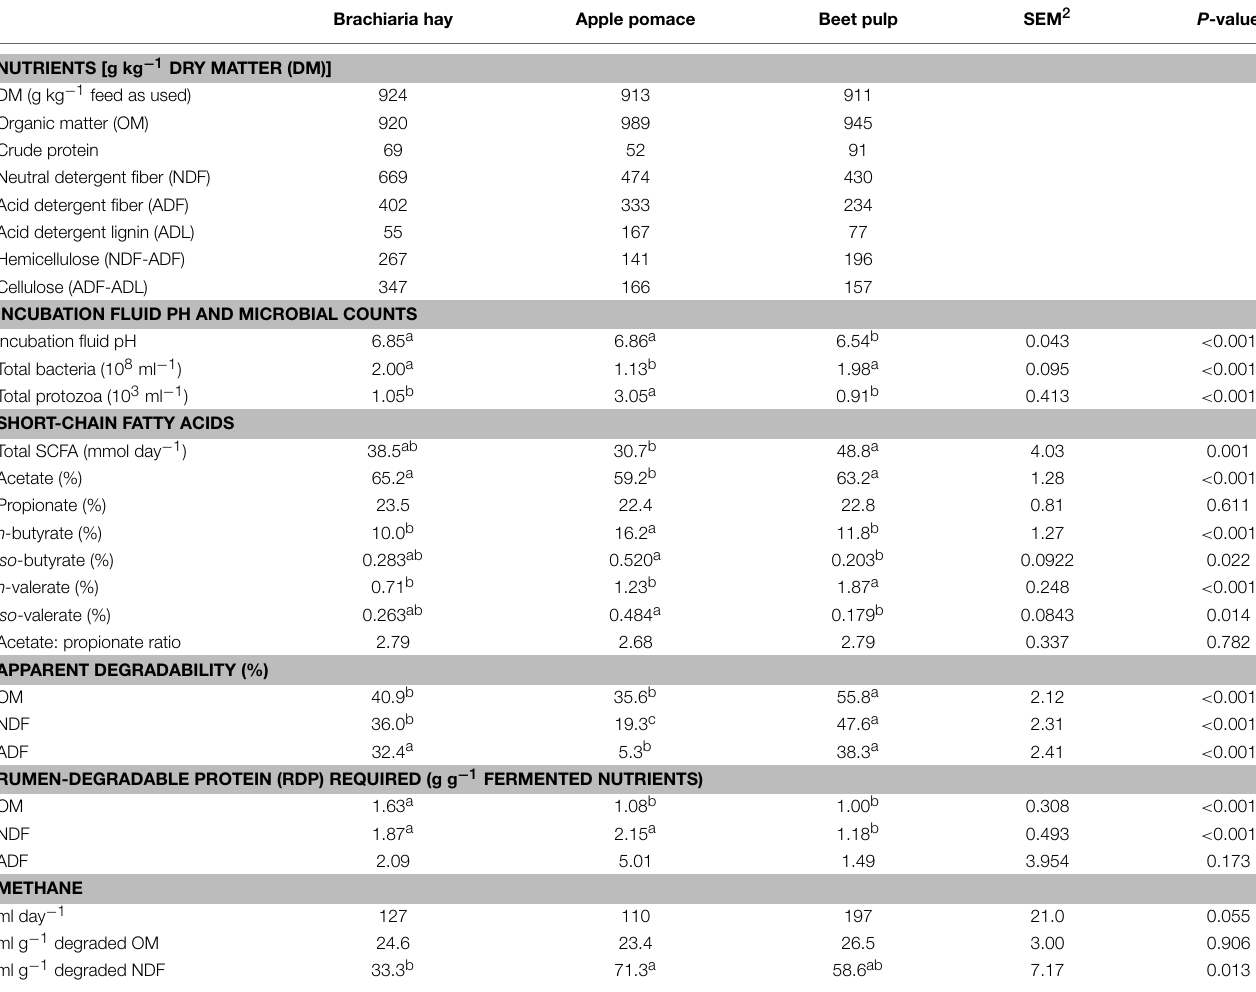
TABLE 1 | Analyzed nutrient composition and fermentation characteristics (average of incubation days 6 through 10) of the three experimental feeds ( n = 7 ; i.e., across all urea supplementations) 1 . Brachiaria hay Apple pomace Beet pulp SEM 2 P